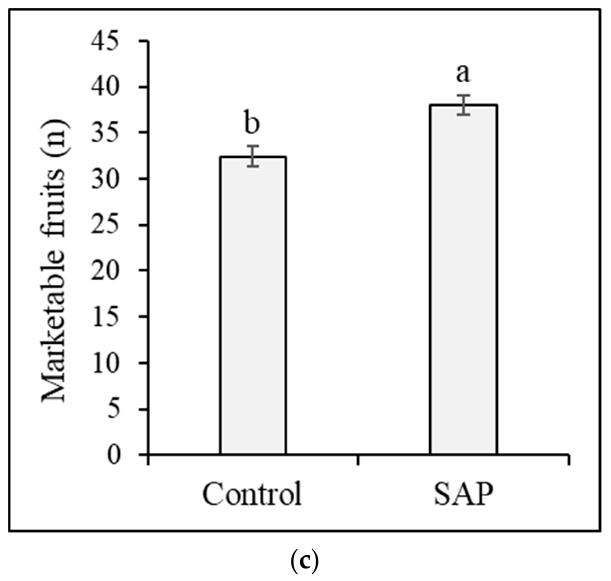
Figure 2. Effect of superabsorbent polymer (SAP) on ( a ) marketable yield and ( b ) total and ( c ) mar- ketable fruits produced per plant. Different letters indicate significant differences at p < 0.05. Vertical bars represent standard errors.